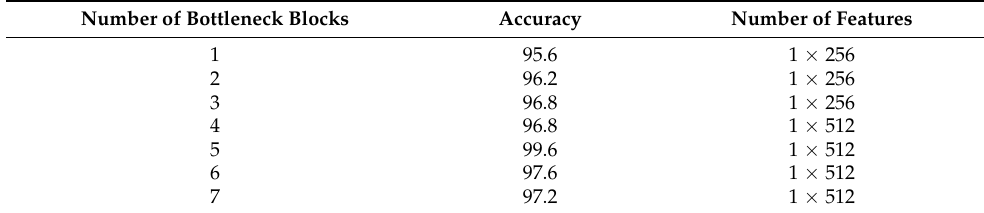
Table 2. Performance of the number of modified ResNet bottleneck